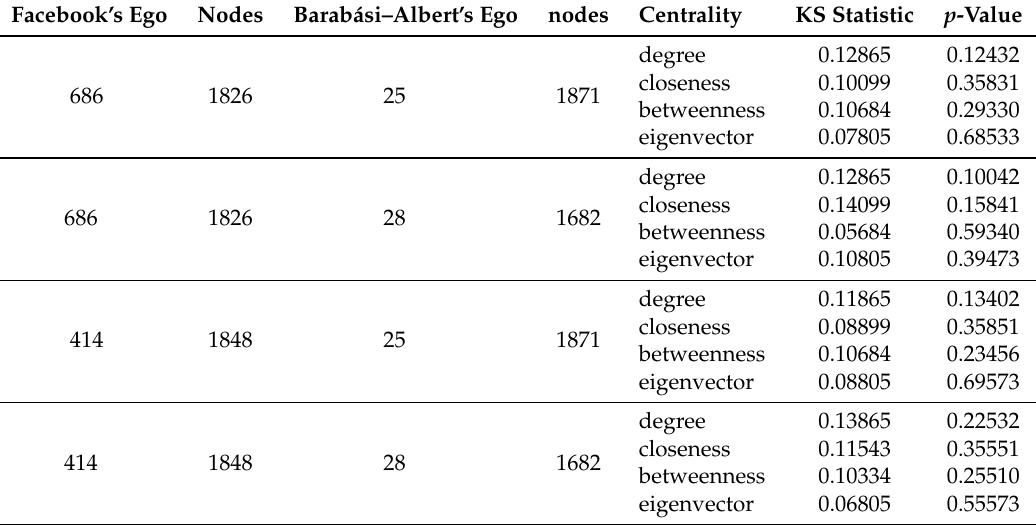
Table 2. Comparing centrality distributions using the Kolmogorov–Smirnov (KS) test for pairs of